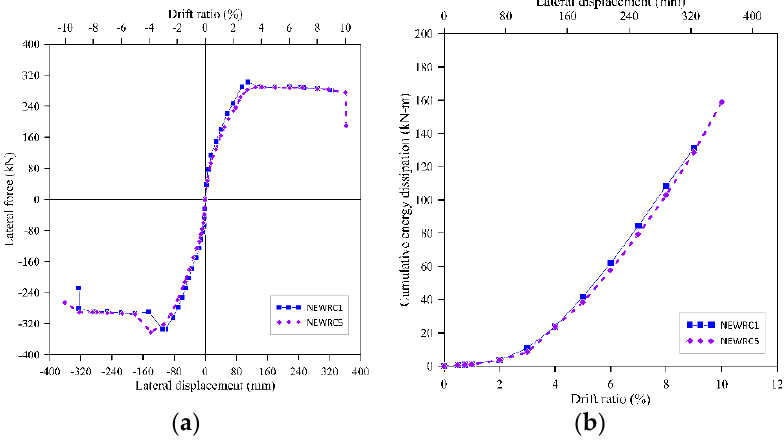
Figure 15. Comparison of NEWRC 1 and NEWRC 5: ( a ) Backbone curve; ( b ) Cumulative energy dissipation.